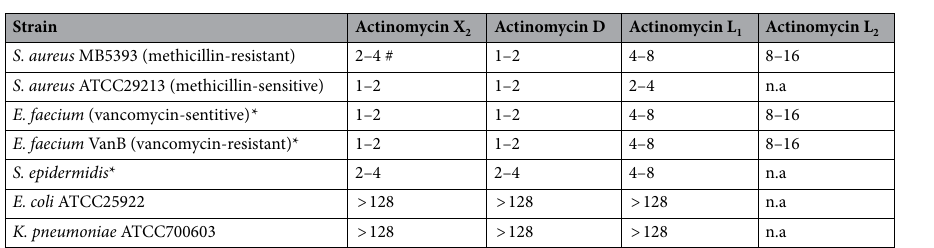
Table 1. Antibacterial activities of compounds expressed as Minimal Inhibitory Concentrations (MIC). (*), Clinical isolates; n.a.: Data not available. # all concentrations given in μg/ml.